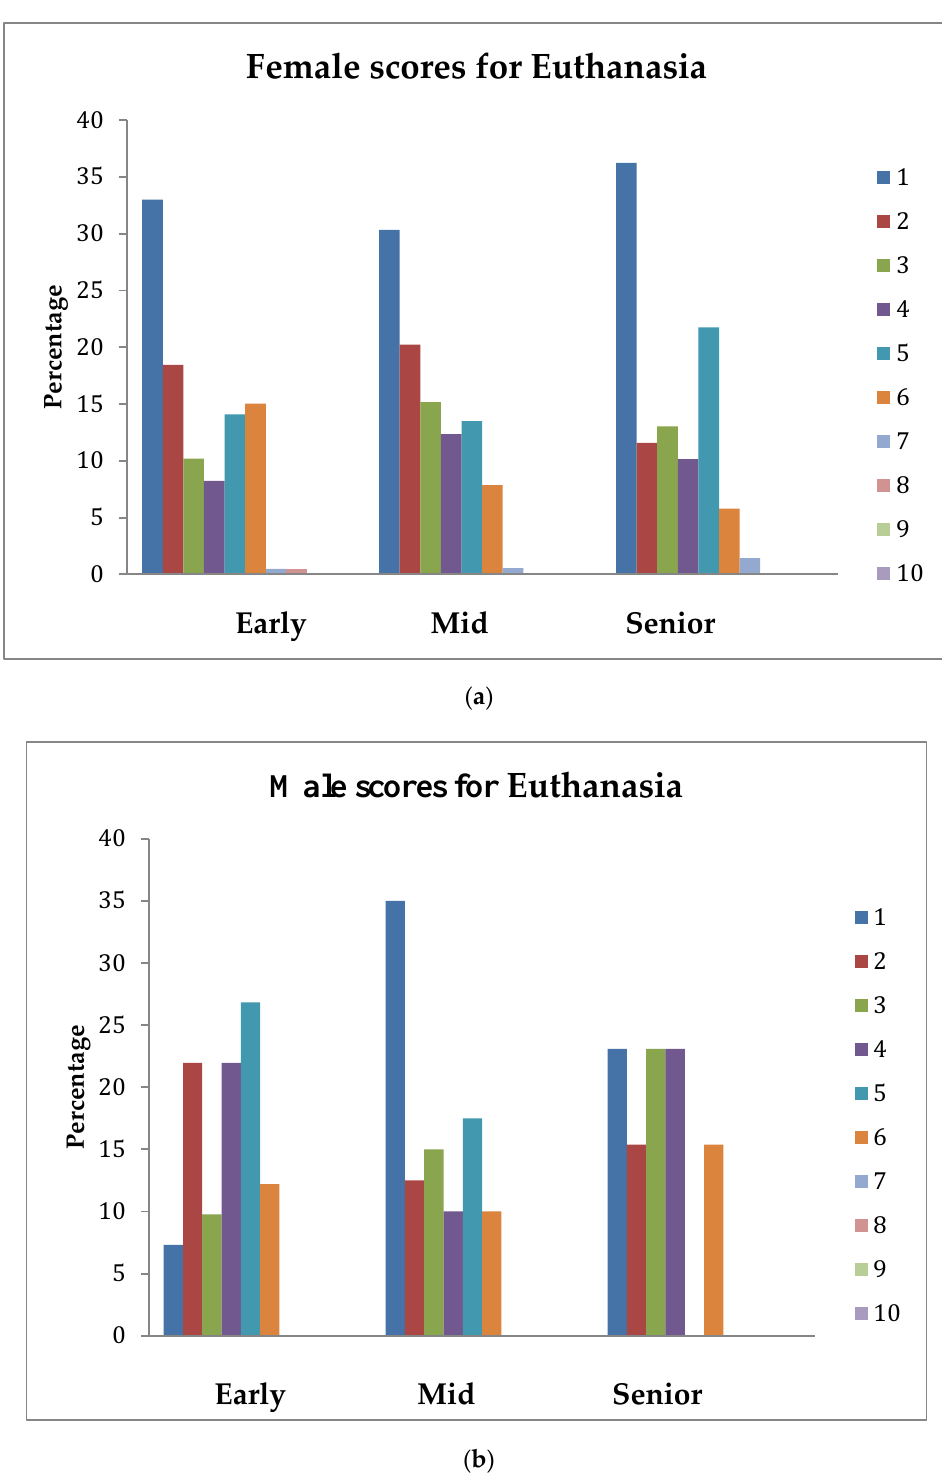
Figure 2. ( a ) Percentage of female students across stage-of-study rating the importance (1 = extremely important, 10 = least important) of an understanding of Euthanasia on their first day in practice; ( b ) percentage of male students across stage-of-study rating the importance (1 = extremely important, 10 = least important) of an understanding of Euthanasia on their first day in